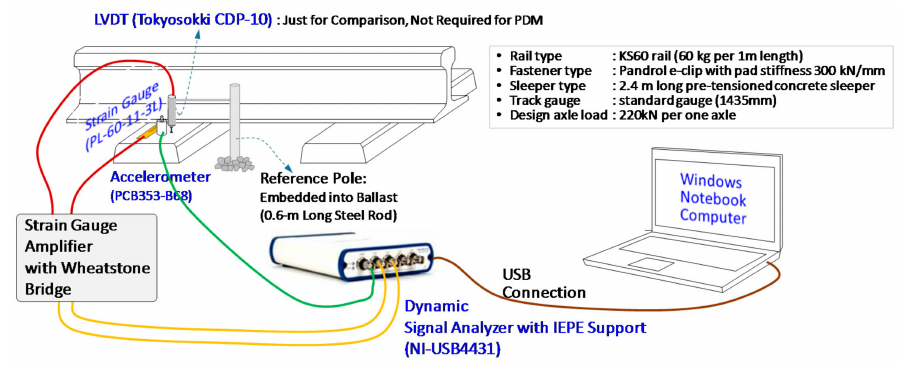
Figure 4. Equipment for the PDM.